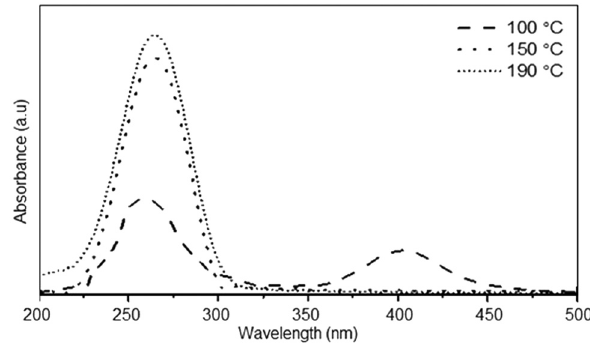
Figure 2: UV - Vis spectra of NiNPs at 100, 150, and